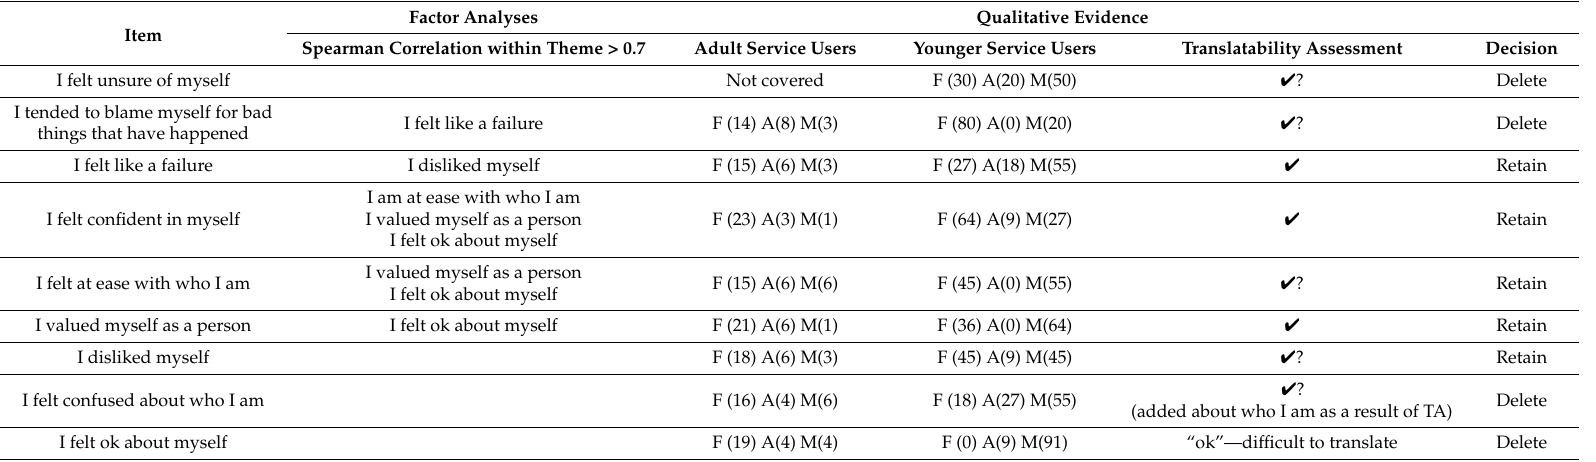
Table 2. Combining the evidence—Study 1 (self-perception theme).